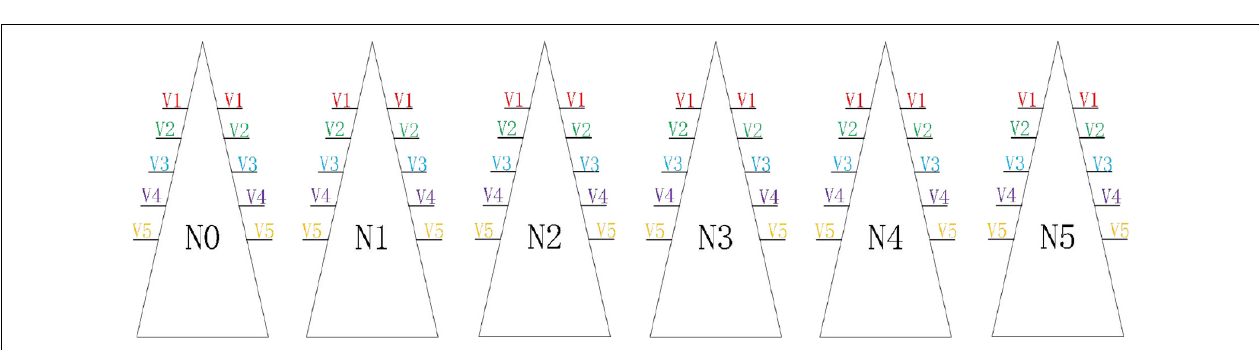
FIGURE 2 | Distribution of lettuce in stereoscopic cultivation racks of 5 varieties. There were a total of 6 cultivation racks, and each cultivation rack was equipped with a nitrogen concentration treatment, and the same variety of lettuce was symmetrically transplanted at the same position on both sides of each cultivation